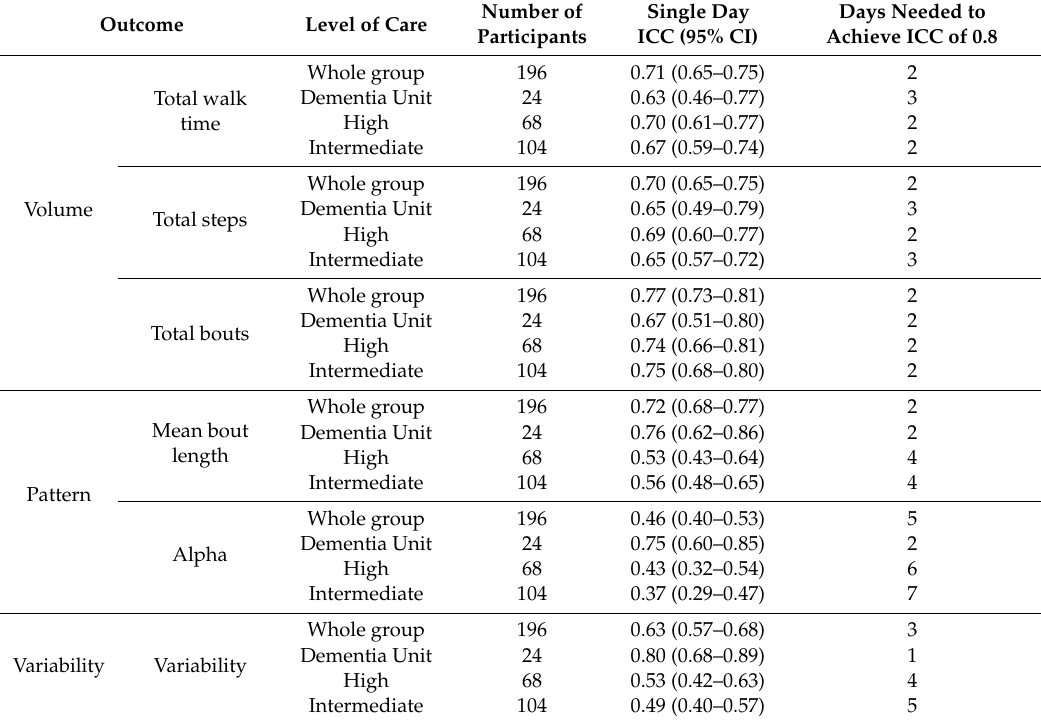
Table 2. The amount of days required for reliable gait outcomes indicative of walking volume, pattern, and variability for the whole population and separated by level of